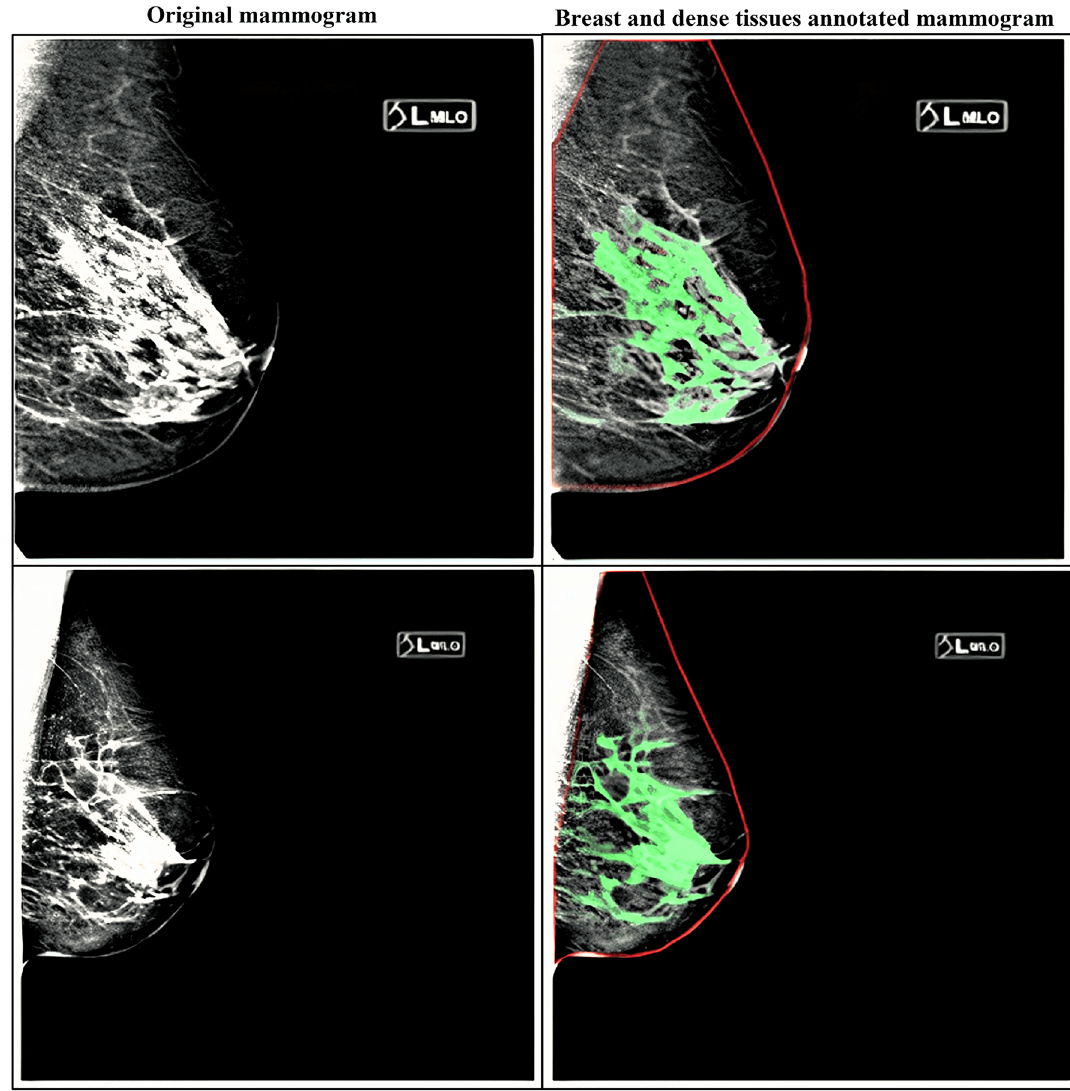
Figure 3. Examples of generated ground-truth segmentation masks from the KUH development set for the breast and dense-tissue segmentation. We overlapped the segmented binary masks on the original